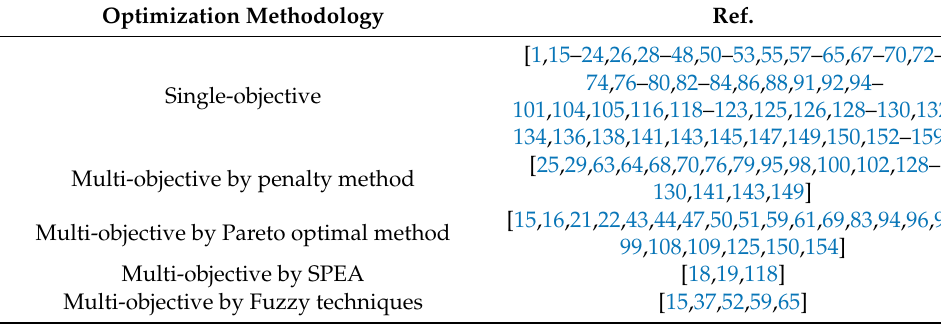
Table 5. Classification of references based on optimization methodologies.